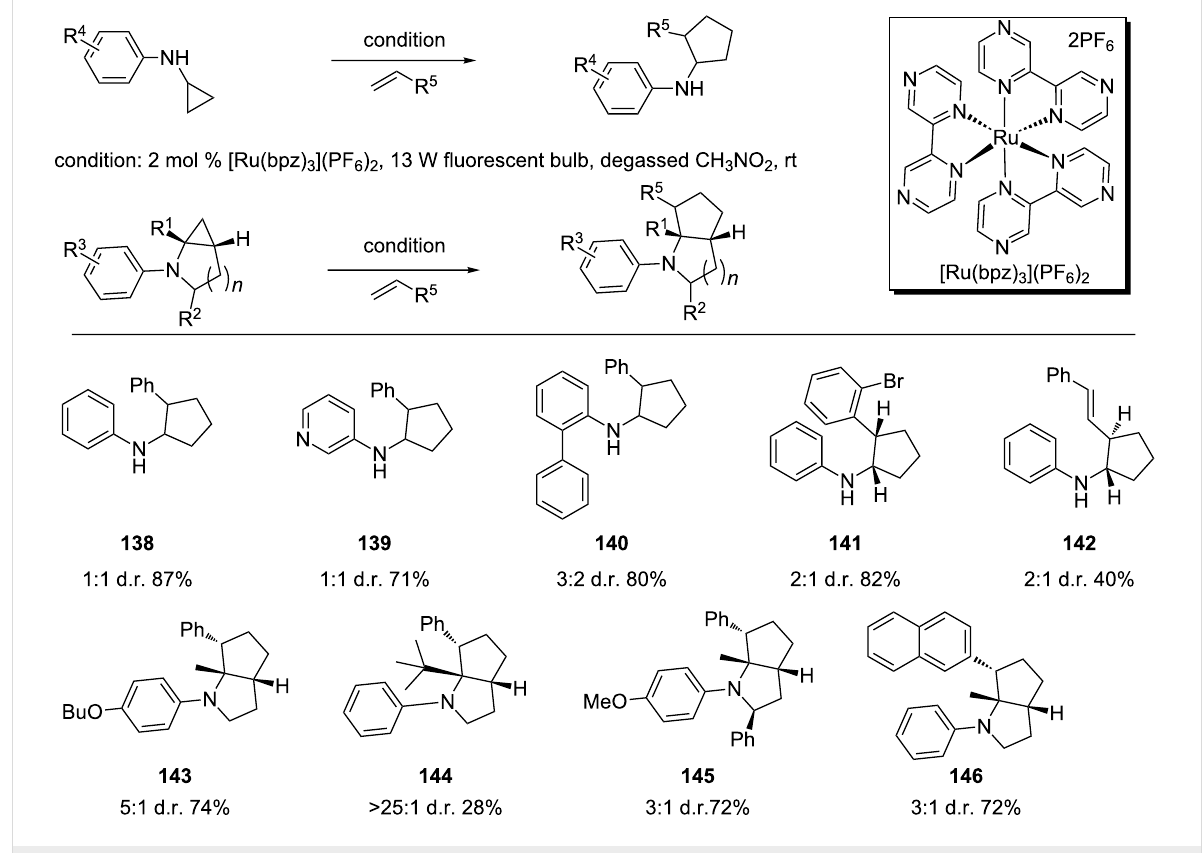
Scheme 32: Intermolecular [3 + 2] annulation of cyclopropylamines with